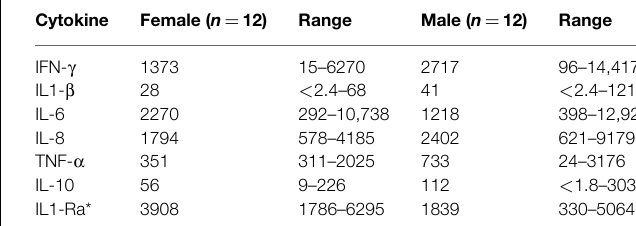
FIGURE 2 | (A) Percentage of singleton stillbirths among all singleton livebirths and stillbirths (prevalence approach). Data are for males (solid blue line) and females (dashed red line), presented by gestational age. (B) Number of stillbirths per 1000 singleton livebirths and stillbirths combined (incidence approach). Data are for males (solid blue lines) and female (dashed red lines), presented by gestational age. Reproduced with permission (17).